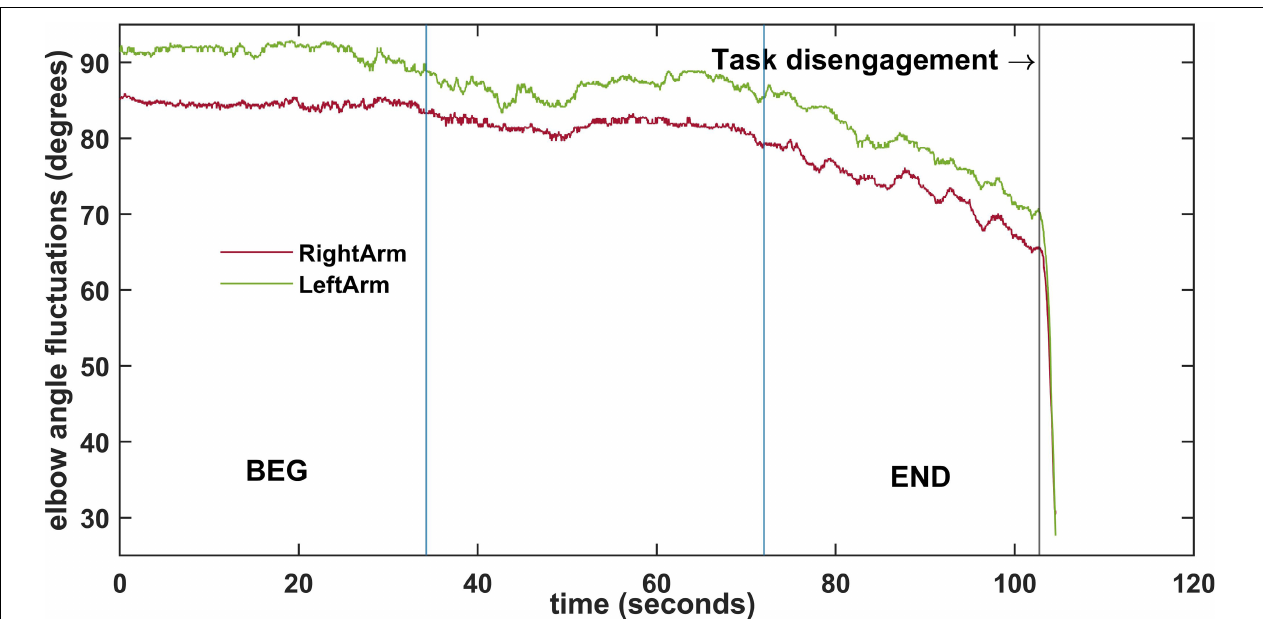
FIGURE 2 | Example of the fluctuations of the elbow angle of both arms during one trial. Vertical blue lines divide the trial into three segments preceding the task disengagement. The first segment (BEG) and the last one (END) were selected for the analysis.